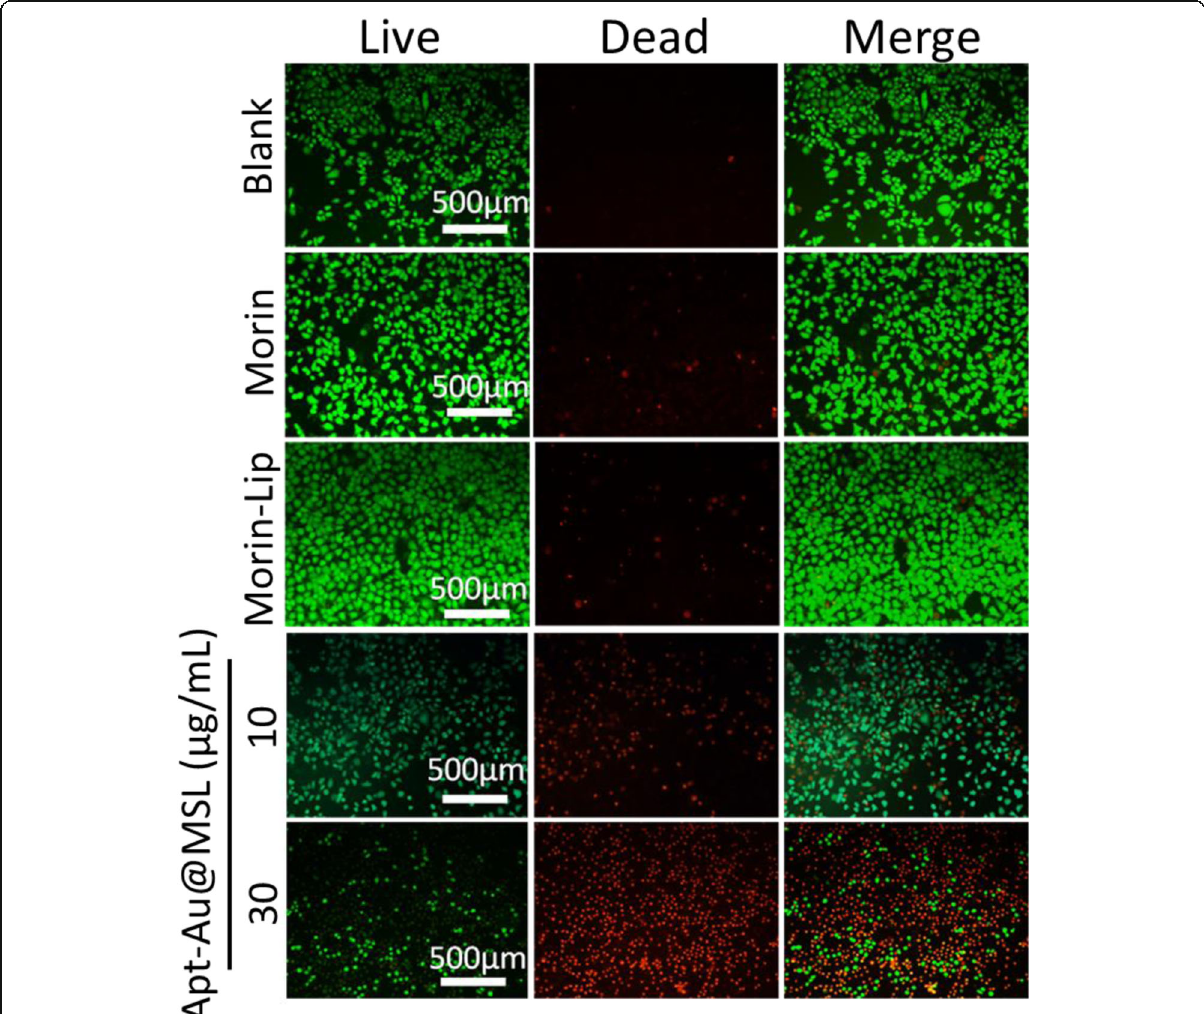
Fig. 6 Fluorescence microscopic images of SGC-7901 incubated with different concentration Apt-Au@MSL and subsequent brief staining. The blank group was PBS. The Morin and Morin – liposome were set as control